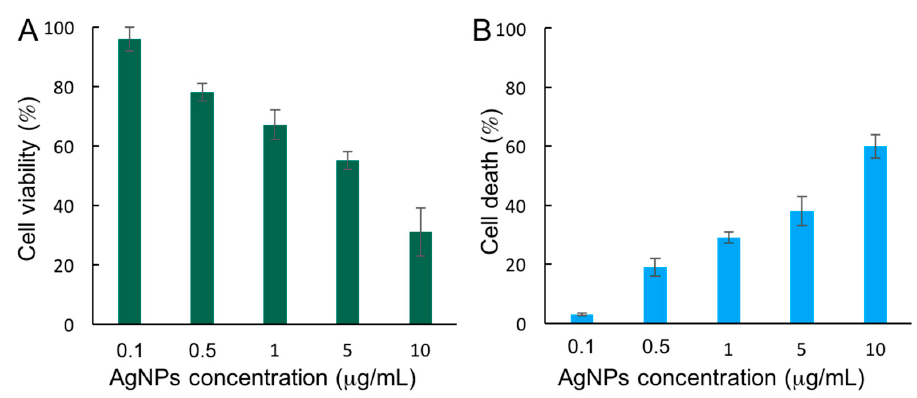
Figure 2. Cytotoxicity of AgNPs: ( A ) MTT-based cell viability assay; ( B ) Trypan blue-based cell death assay.